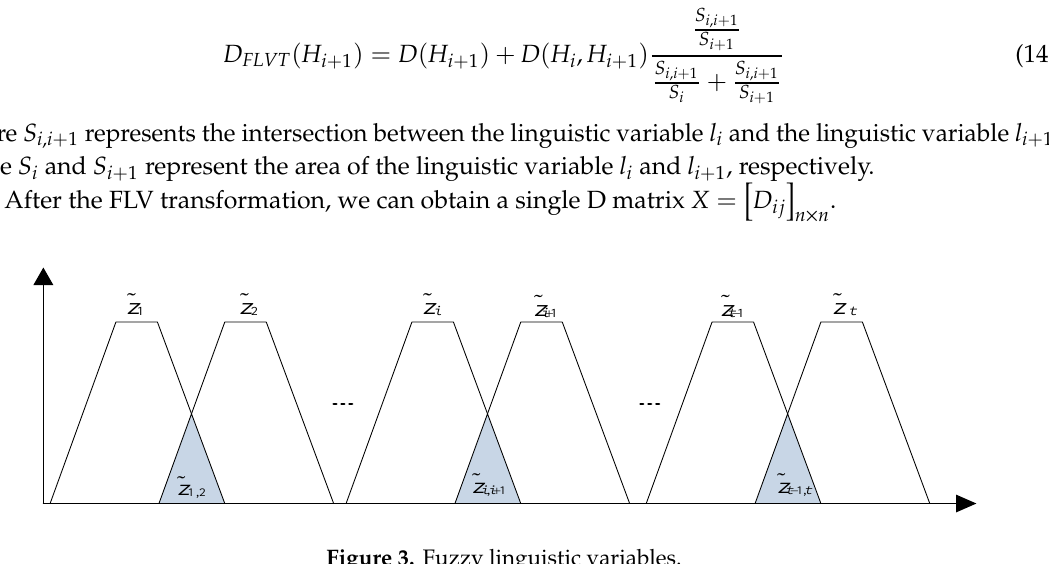
Figure 3. Fuzzy linguistic variables.